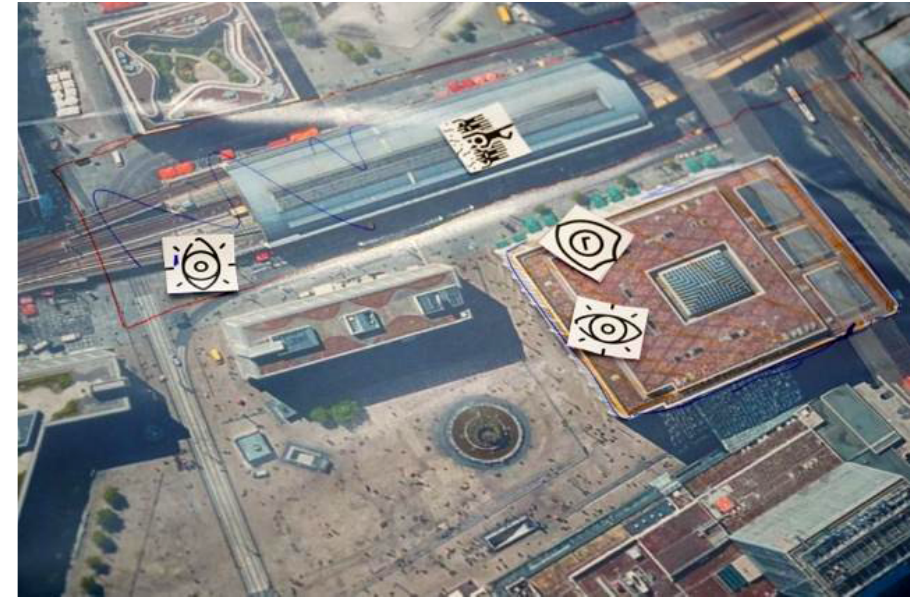
Figure 4. Participatory mapping for security perceptions. Source: